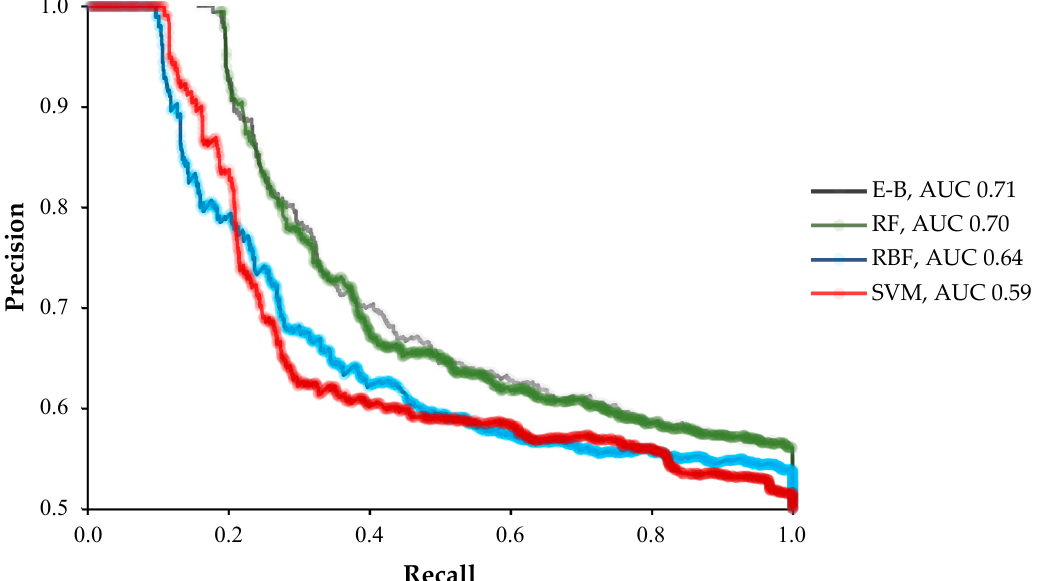
Figure 4. The area under the precision recall curves (PRC; AUC-PRC) of the radial basis function (RBF), support vector machine (SVM), random forest (RF), and ensemble-bagging (E-B) algorithms for off-target activity prediction using MIT and CDF scores.